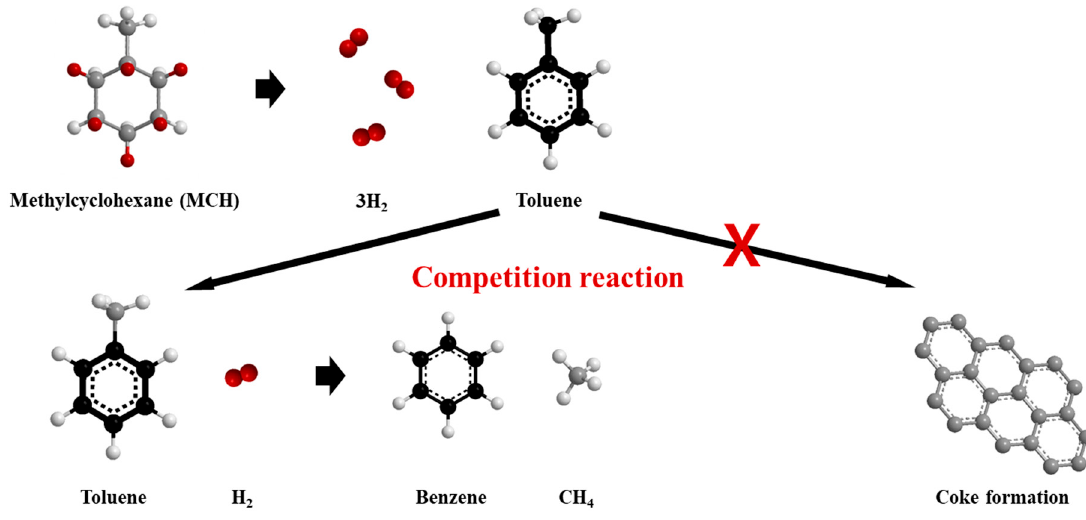
Figure 8. Overall product distributions at 450 °C and 4 MPa.